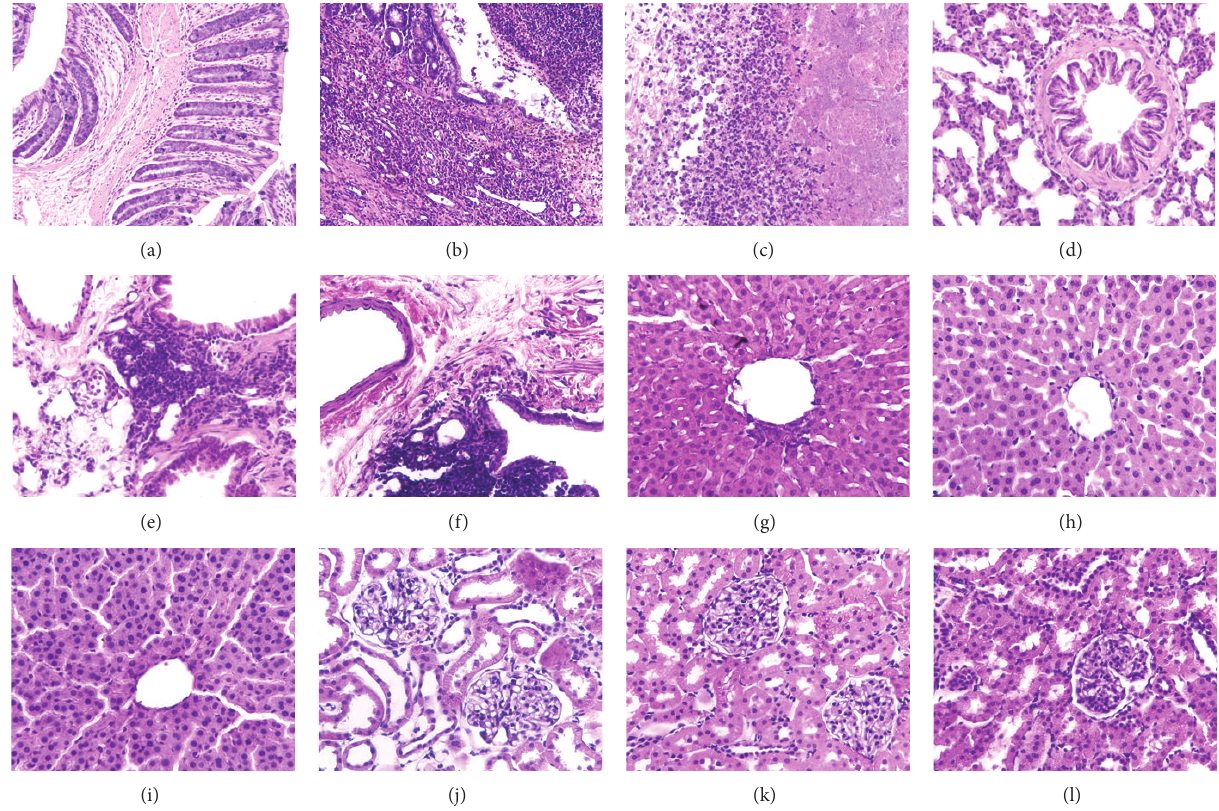
Figure 3: Histological findings in the colon, lung, liver, and kidney of the normal and UC rats (hematoxylin and eosin stain, × 100). (a) The colonic mucosa structure in the normal rats was intact. (b) The colonic mucosa and submucosa defects could be clearly seen with infiltrations of inflammatory cells in the lamina propria of after TNBS-ethanol enema (24 hours). (c) Four weeks later, colonic tissue necrosis was obvious, and some necrotic tissues stripped and formed ulcers. The glands of the lamina propria atrophied or even disappeared. (d) The lung tissue had normal alveolar structure and no inflammatory infiltration and exudate. (e) After TNBS-ethanol enema, the lung tissue can be seen massive lymphocytes, even lymphocytic nodules around the bronchi. (f) Four weeks later, blood vessel wall and bronchial wall were obvious group, and (i): model 4 group). The structure proliferation. (g)–(i) Rat liver structure was basically normal ((g): normal group, (h): model 24 h w of hepatic cords was clear, liver cells distributed radially around central venous and less fat vacuoles, and the structure of hepatic lobules was intact. (j) The histological appearance of the normal kidney was shown. (k) and (l) Compared with the normal group, glomerular cells and mesangial matrix of the model rats had no significant necrosis and